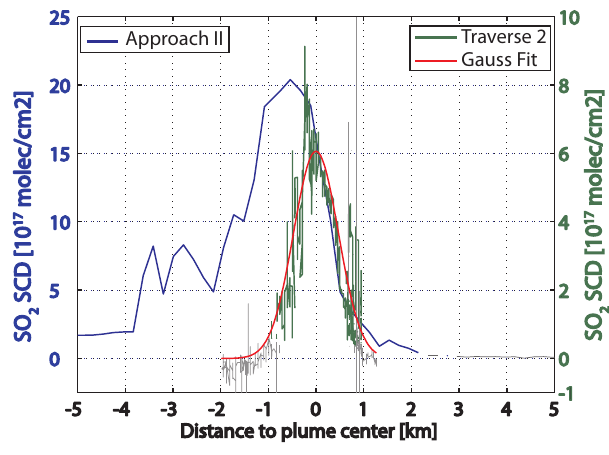
Fig. 8. Comparison of results from car traverses and airborne measurements, with scale of measured SO 2 SCDs on the right and left ordinate, respectively. Values below 3x measurement error are drawn in grey. Strong variations in the car traverse (e.g. at 1km from plume centre) are artefacts due to vegetation blocking the view. The gradients shown agree with expected characteristics of transition between regime B to regime C (see Fig. 1), although the starting point of the plume of the car traverse does not correlate with the maximum of the values retrieved from the airborne mea-